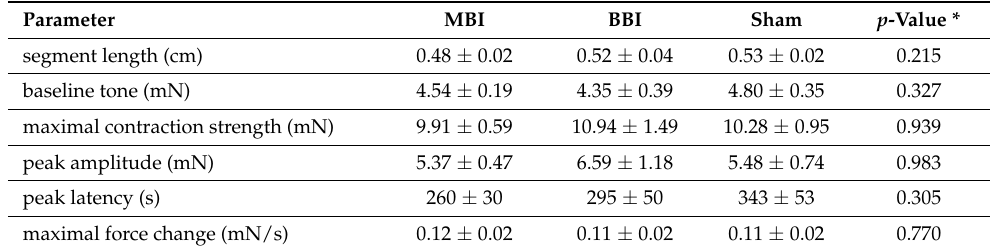
Table 2. Functional parameters before